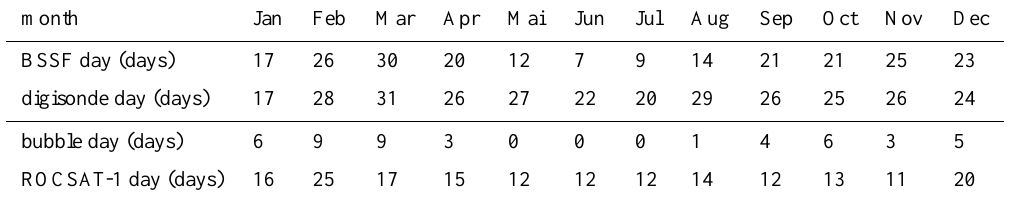
Fig. 3. Illustration of the bubble distribution in altitude and in relation to the geomagnetic fields. An equatorial bubble can rise to high altitudes and extent via the geomagnetic field to high latitudes as ∼ 16 ◦ dip latitude (gray area) where the crest of equatorial ionization anomaly is located. When a bubble intersects the anomaly crest, it is detectable at 600km between ± 15 ◦ dip latitude by the ROCSAT-1. Table 1. Numbers of BSSF day, digisonde day, bubble day, and ROCSAT-1 day for each month during April 1999–March